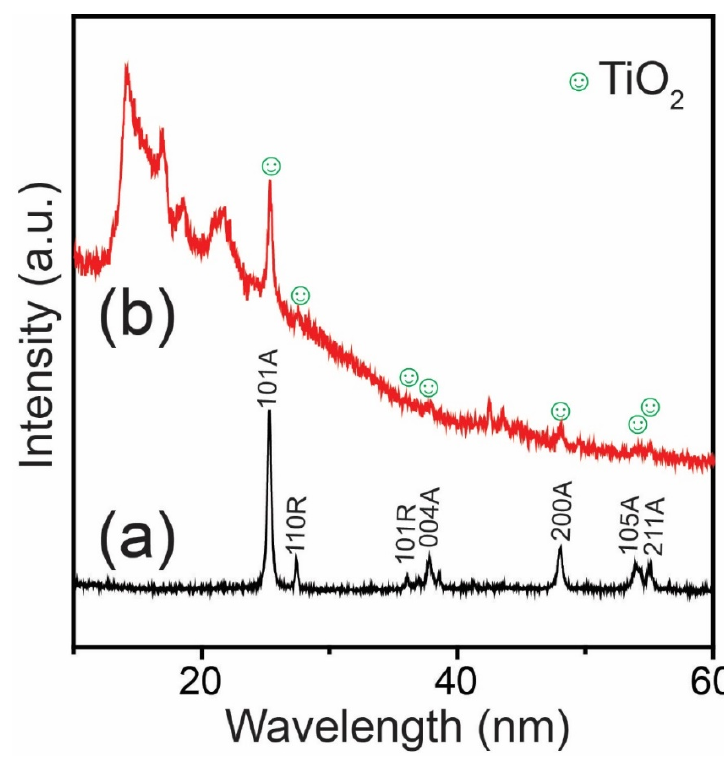
Figure 5. XRD spectra of ( a ) TiO 2 NPs and ( b ) PPM + TiO 2